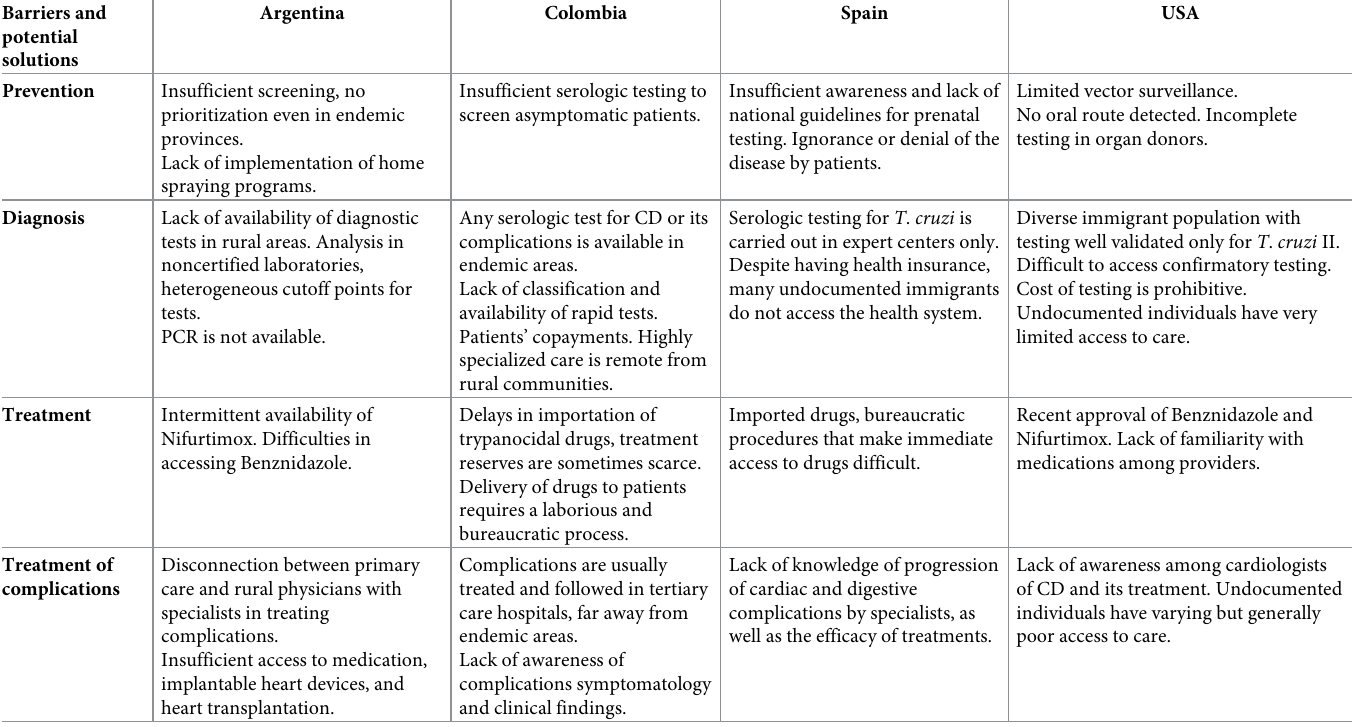
Table 1. Specific roadblocks by country to access optimal care of CD integrated with SIAC-WHF roadmap. Barriers and